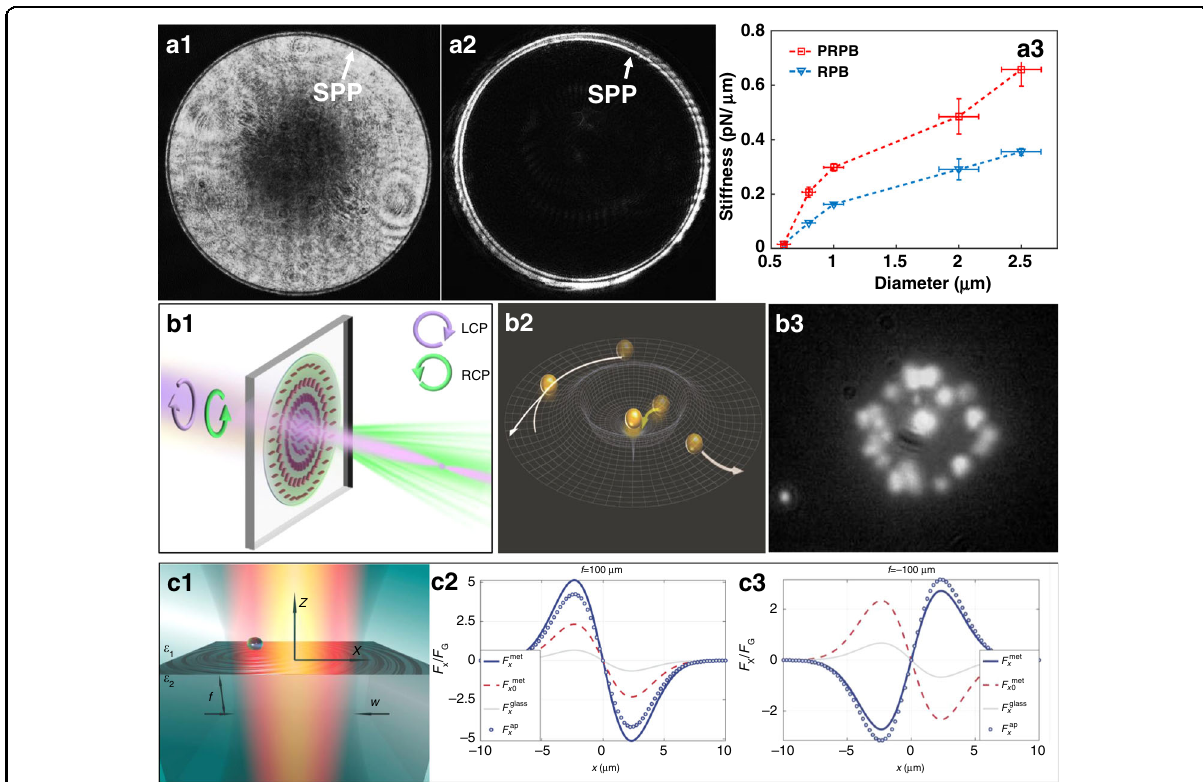
Fig. 11 Performance improvements of plasmonic tweezers on a smooth surface. a Stiffness improvement with the use of a perfect radially polarized laser compressed in a thin ring that satis fi es the SPP excitation conditions. b Selective trapping of metallic nanoparticles with tailored plasmonic fi elds. b1 : Schematic of the polarization-directed fl at metal lens, b2 : schematic force distribution and b3 : experimental results of Au particles in a tailored plasmonic fi eld. c Surface plasmon excited on a fl at silver surface to generate switchable plasmon-assisted trapping and antitrapping effects. c1 : Schematic of the system, and c2 – c3 : optical force acting on a particle touching the substrate and illuminated by a Gaussian beam focused above or below the substrate interface. a Reproduced with permission of ref. 164 , Copyright 2018, Chinese Laser Press. b Adapted